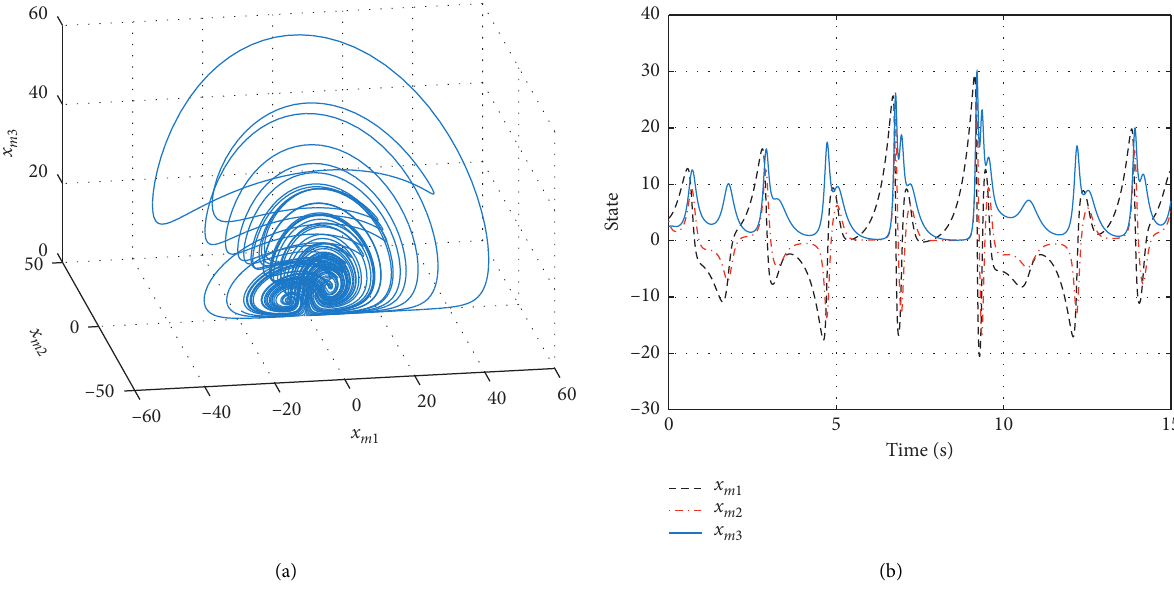
Figure 1: Chaotic behavior of the system without the control input. (a) Phase portrait of the system. (b) System states x